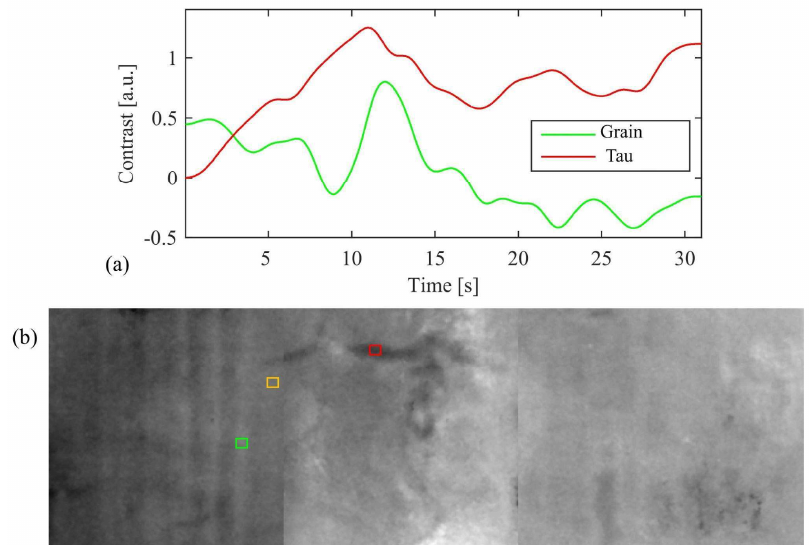
Figure 6. ( a ) Thermal contrast for the grain (green) and tau (red) pixel areas as a function of time. A maximum is reached for both quantities at t = 13 s; ( b ) a thermogram showing the investigated area at t = 13 s, marked to highlight the areas employed for computing the thermal contrast, i.e., tau within the red square, wood grain within the green square, and sound within the orange square.